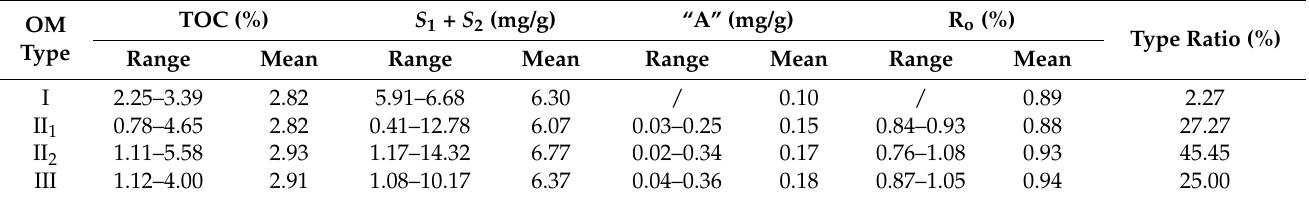
Figure 2. The characteristics of OM abundance in K 1 yc 4 in the South Shuangcheng Fault Depression: ( A ) TOC content; ( B ) hydrocarbon generation potential S 1 + S 2 ; ( C ) chloroform bitumen “A”. Table 1. The organic geochemical characteristics of K 1 yc 4 in the South Shuangcheng Fault Depression.